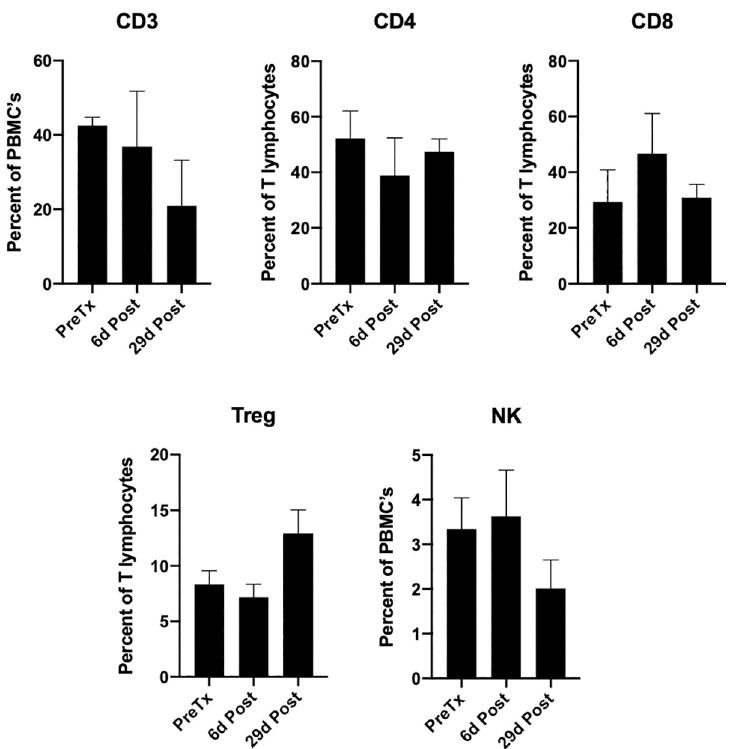
Fig 10. Composition of circulating T cells. The relative frequency of T and NK cell subsets (mean percent +/- SEM) in the peripheral blood of 3 dogs with advanced stage melanoma at serial time points during multimodality immuno- radiotherapy. Percentage of expression is based on cells within a lymphocyte gate described by a Forward versus Side Scatter flow cytometry plot.